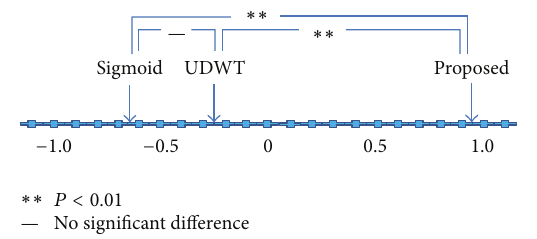
Figure 8: Preference ranking map for the three image groups: STWC-mapping-method-processed, modified-UDWT-processed, and proposed-method-processed chest